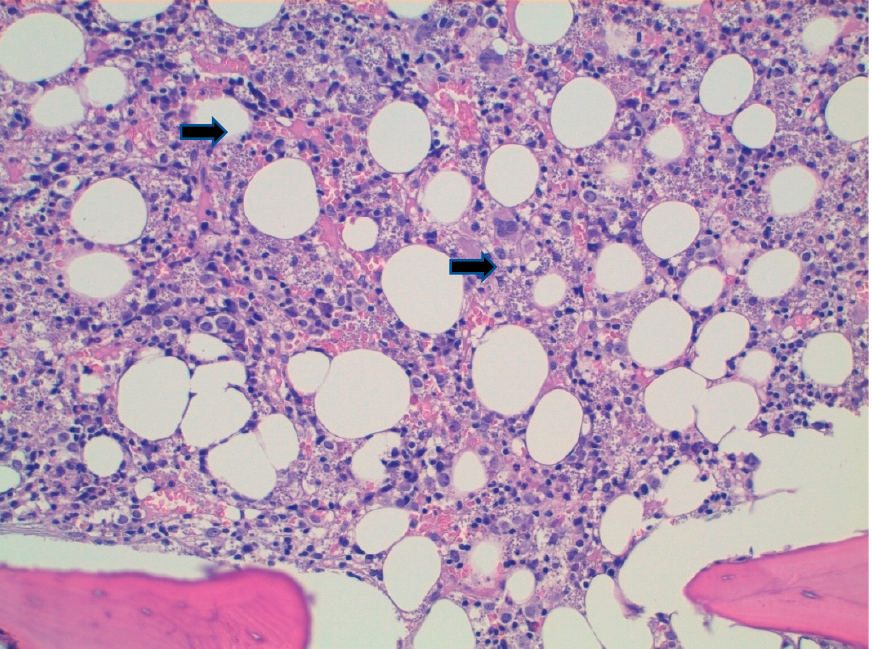
Figure 2. Hematoxylin-eosine stain on osteomedullary biopsy showing amastigotes (black